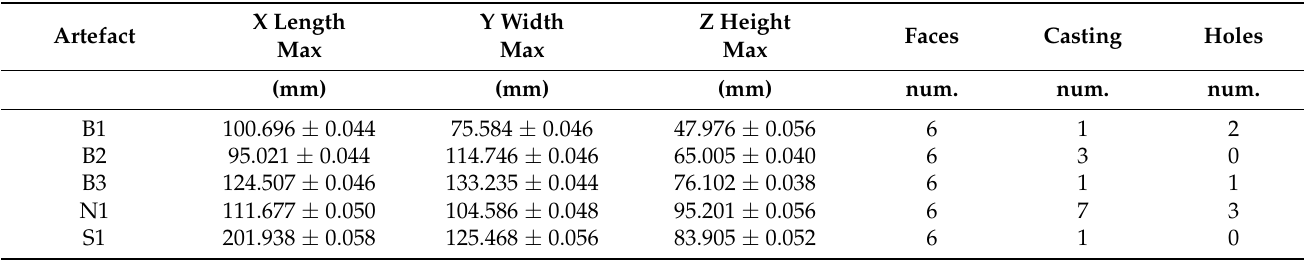
Table 7. Dimensional characteristics of the archaeological artefacts (X, Y, Z direction) calculated by CloudCompare software. Artefact